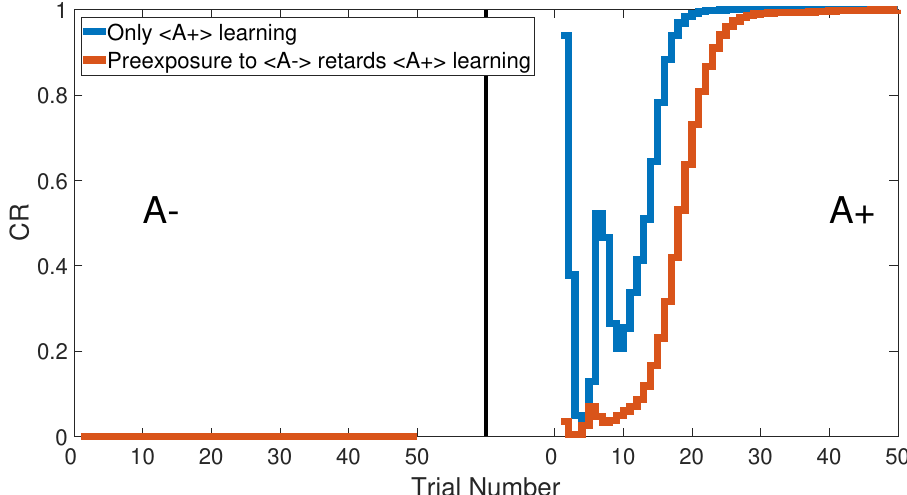
Figure 22. Latent inhibition task for the intact system of CHCQ model with and without a pre-exposure.